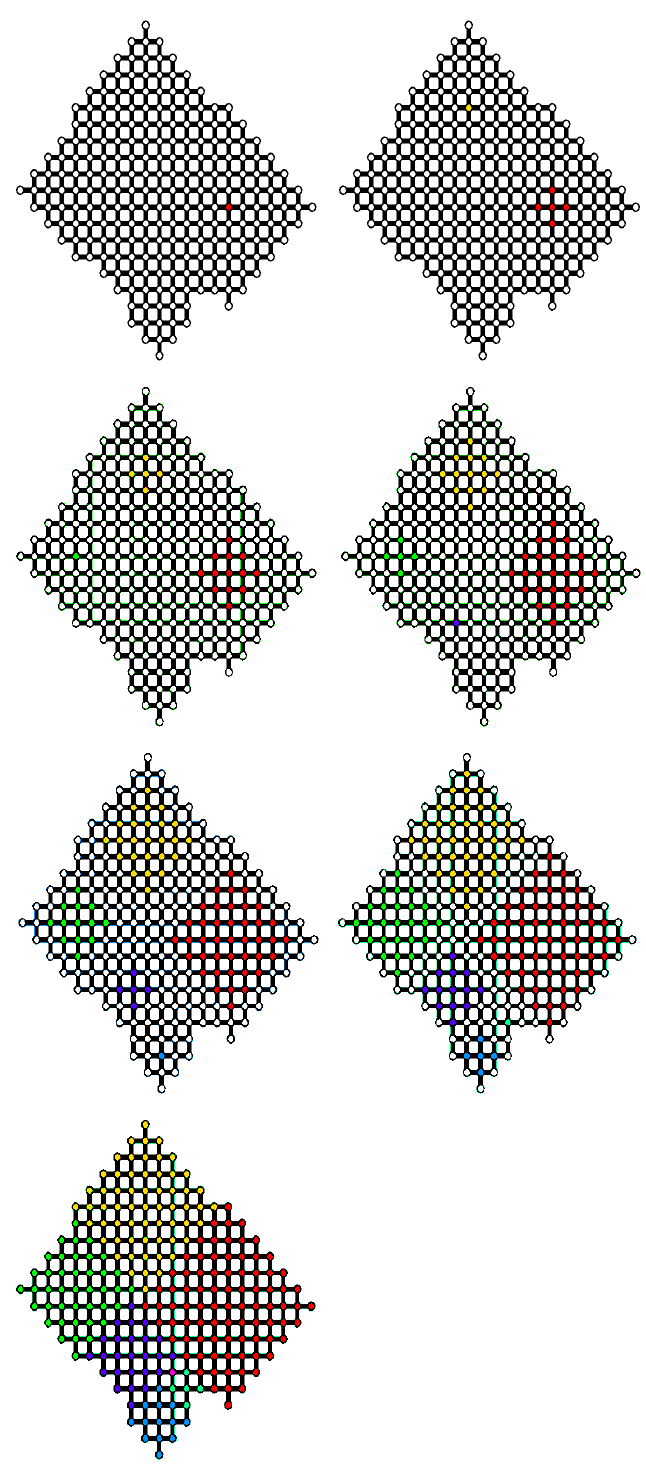
Figure 1. An example of single time steps in process of the burning of a graph (the graph is further referred to in Table 1 as squaredIdealBurn7).